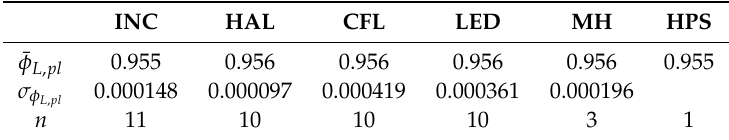
Table 7. The mean ( ¯ φ L , pl ), standard deviation ( σ φ ), and sample size ( n ) of the exergy-to-energy ratio L , pl when using the photopic luminous weighting function, by lighting technology. INC HAL